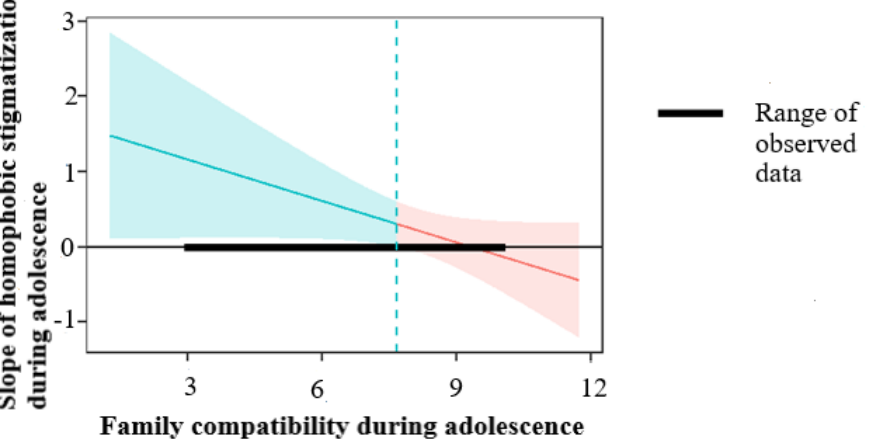
Figure 1. Johnson-Neyman plot. Note. The area on the left side of the dashed line is significant at p < 0.05.